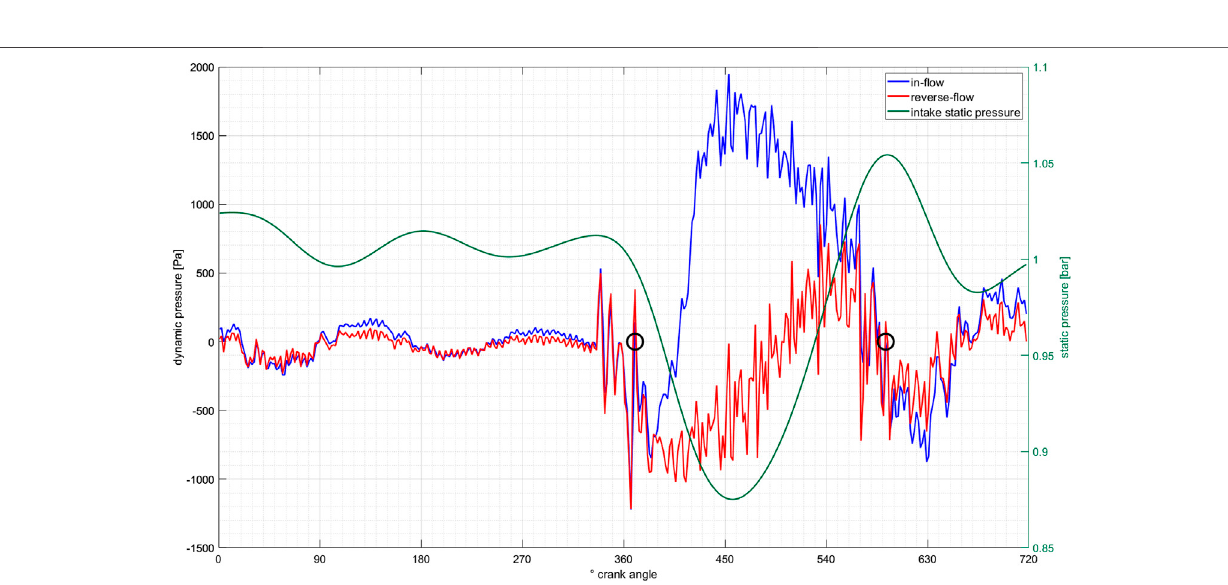
Frontiers in Mechanical Engineering |